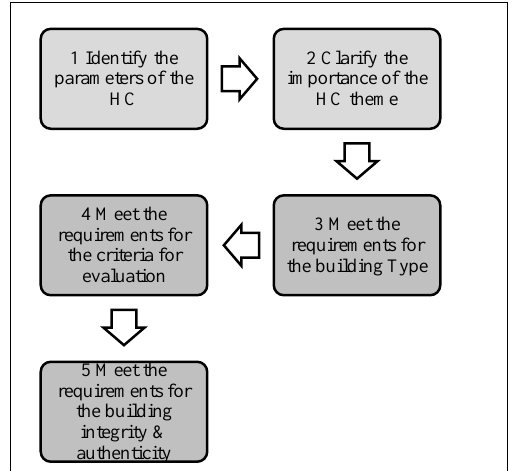
Figure 3. Significance assessment steps with their implication on information